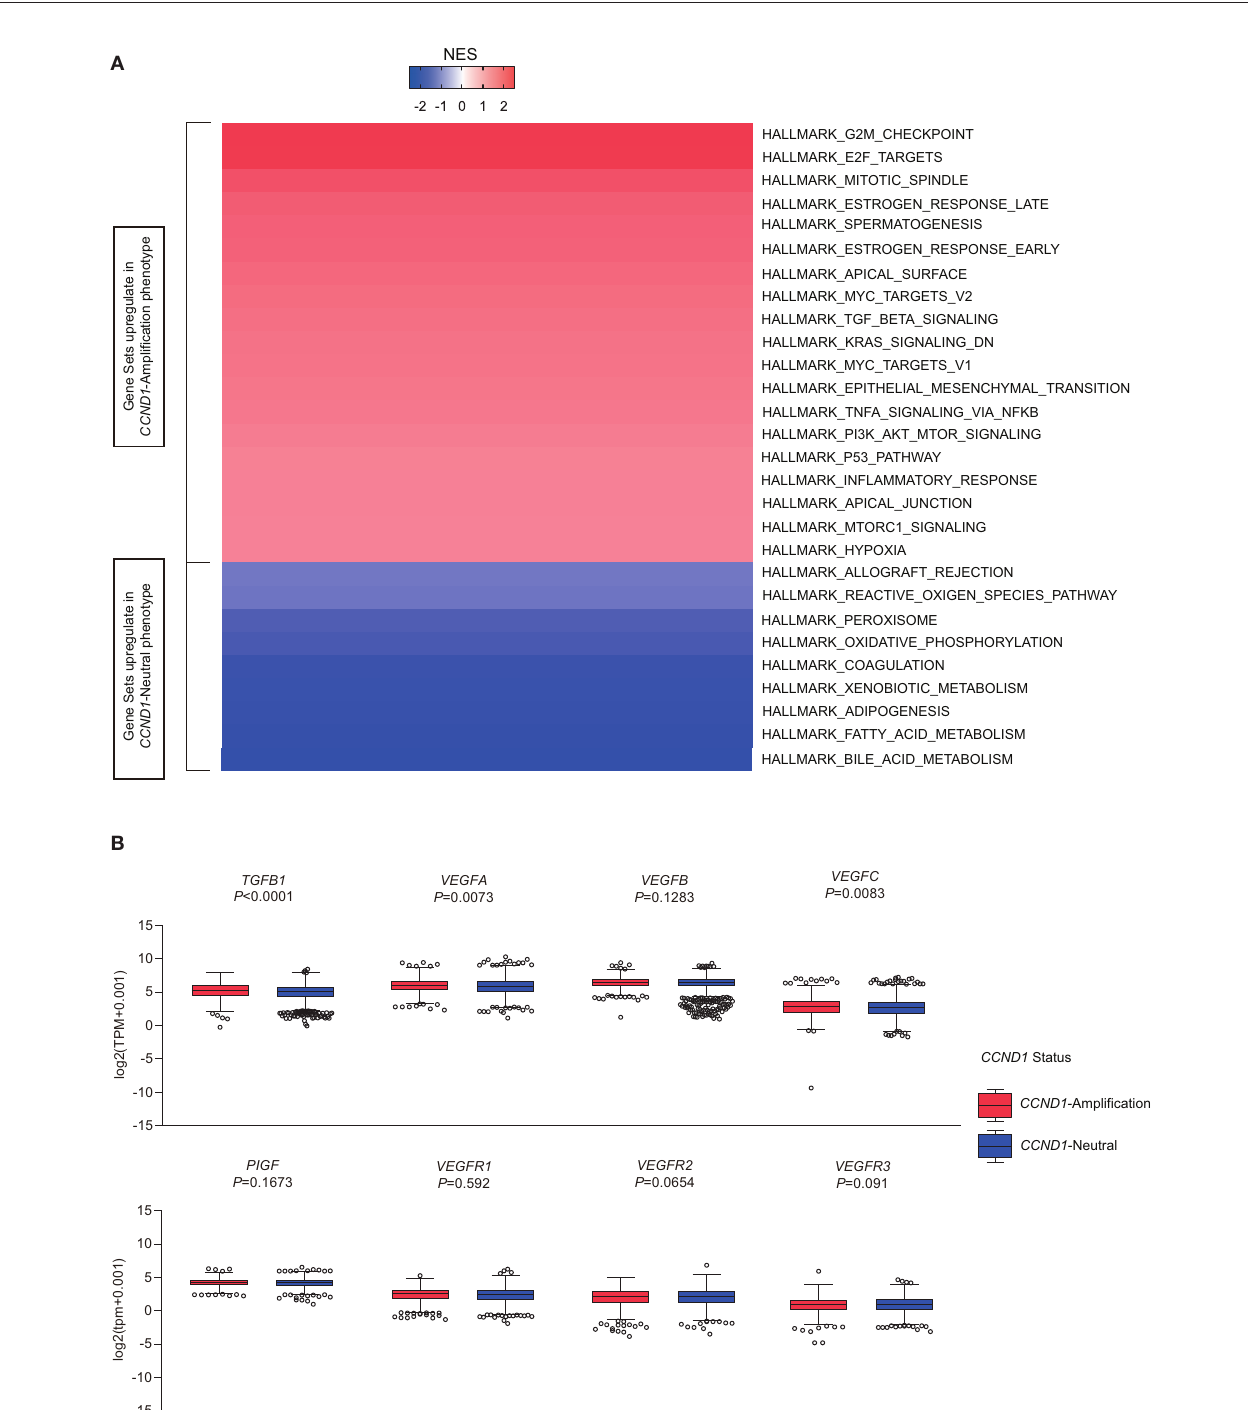
Frontiers in Immunology |